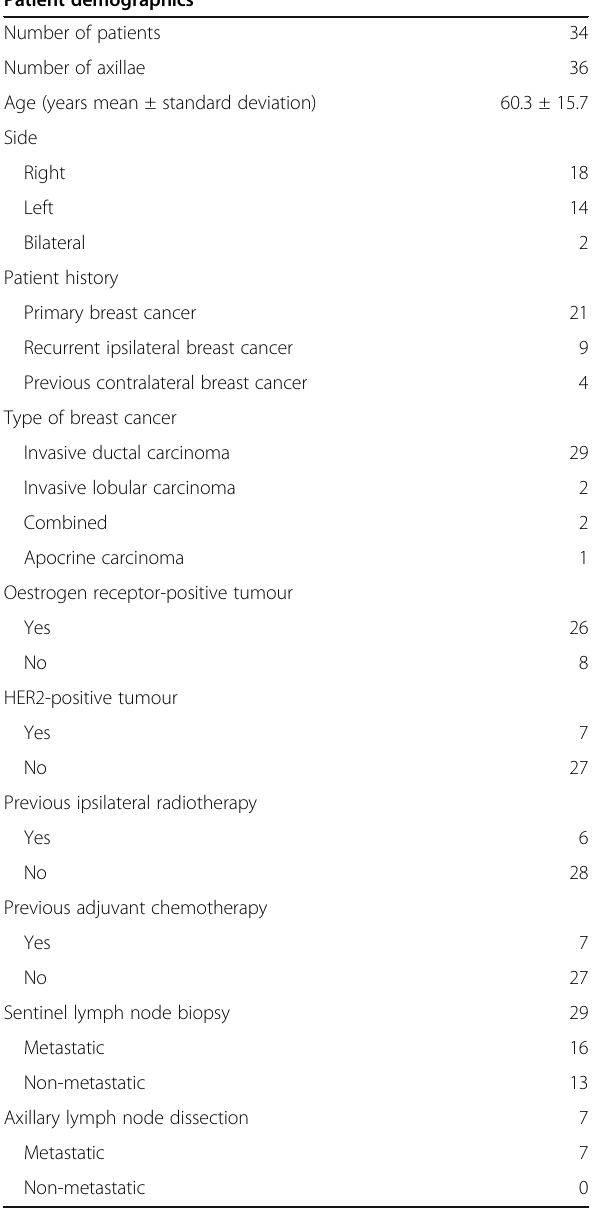
Table 1 Patient demographics and clinical